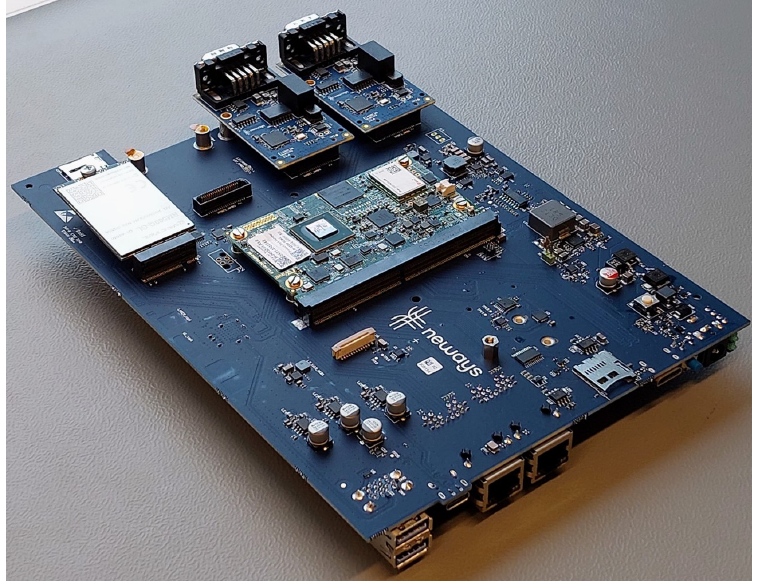
Figure 17. GWEN without enclosure (November 2022